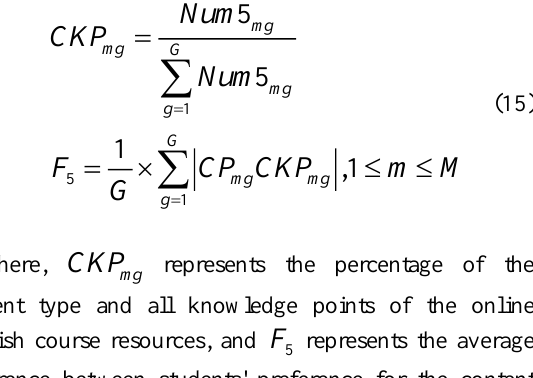
Figure 7. knowledge module of English course